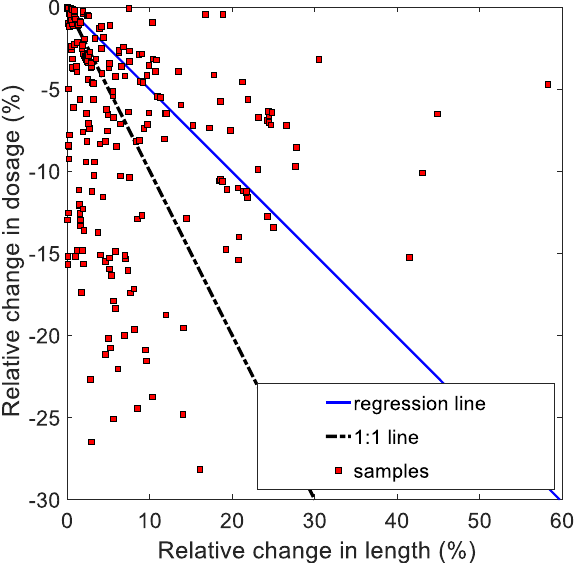
Figure 3. Scatterplot of relative change in route length vs. relative change in dosage. Averagely, ALDRs (3072.63 m) were 7.78% longer than their corresponding shortest- distance route (2850.92 m) in terms of mean route length, and the mean NO 2 dosage of ALDRs (4.06 µ g) was 7.79% lower than that of its counterpart (4.40 µ g). Statistically, the benefit (e.g., reducing inhaled NO 2 dose) of using an ALDR equaled (or marginally out- weighed) the corresponding cost (e.g., riding more route length). However, the regression line (blue) in Figure 3 was on the right side of the 1:1 line (black), which indicates that